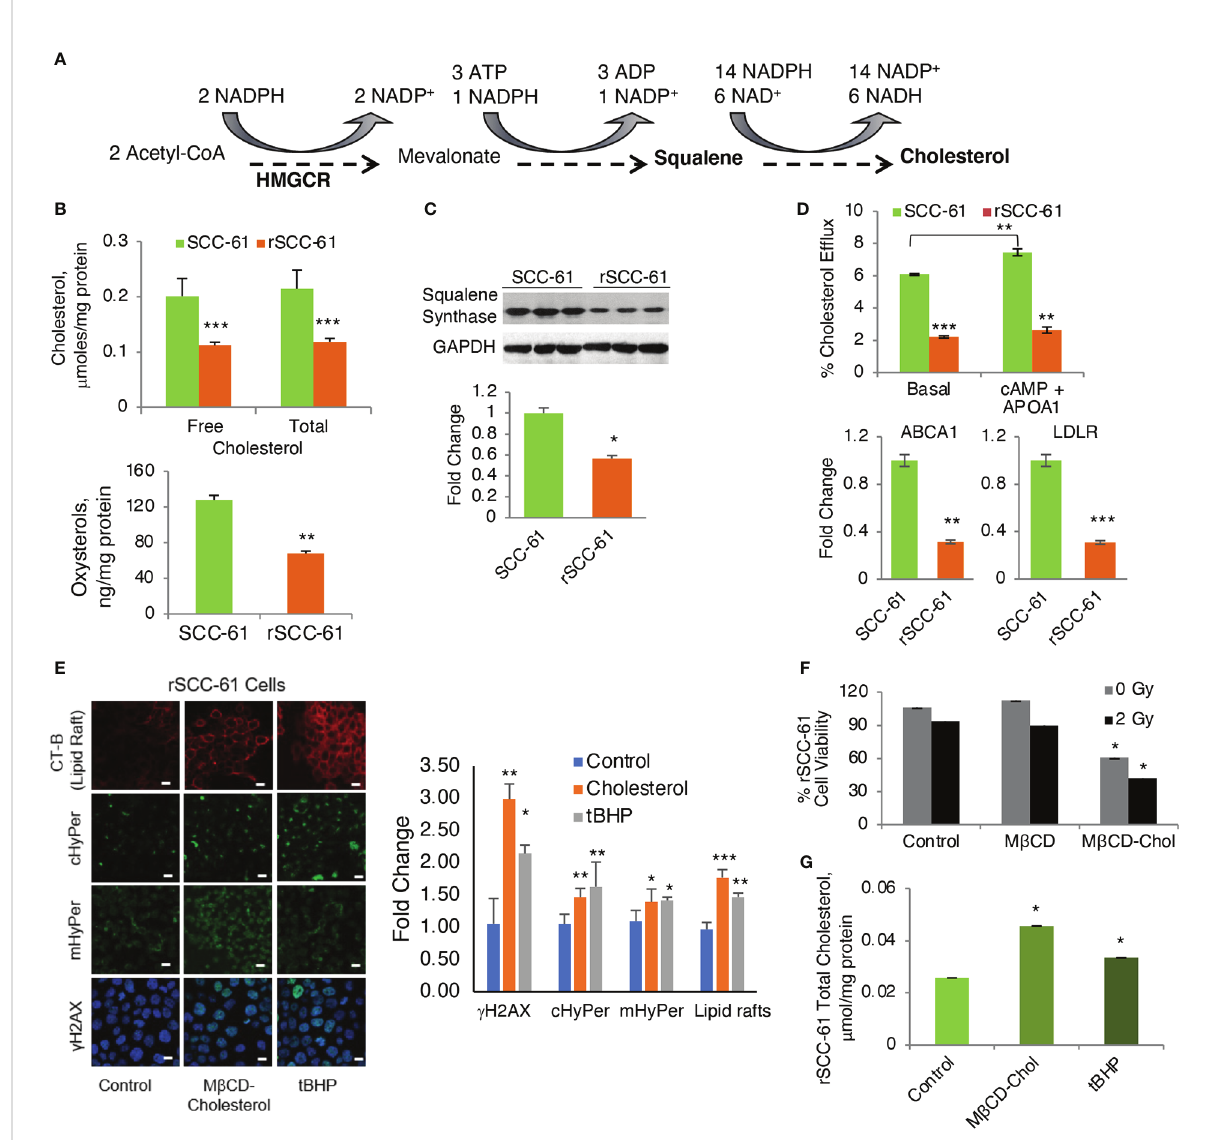
FIGURE 6 Regulation of Cholesterol and Its Impact on the Response to Radiation. (A) Abbreviated schematic of cholesterol biosynthesis showing the key NADPH consuming reactions. (B) Quanti fi cation of cholesterol and oxysterols by mass spectrometry showing signi fi cantly decreased cholesterol and oxysterols in rSCC-61 cells ( p values **0.01-0.001, ***<0.001, n=3). (C) Western blot analysis of squalene synthase showing decreased expression in rSCC-61 compared to SCC-61 cells. Quanti fi cation is shown in the lower panel ( p value *0.05-0.01). (D) Cholesterol ef fl ux and uptake showing (upper) basal and maximal ef fl ux in SCC-61 and rSCC-61 cells after treatment with cAMP and human APOA1, and (lower) Relative quanti fi cation of ABCA1 responsible for the ef fl ux offree cholesterol and LDLR involved in the uptake of cholesterol esters in SCC-61 and rSCC-61 cells show both their gene transcript levels to be lower in rSCC-61 cells ( p values **0.01-0.001, ***<0.001, n=3). (E) (left) Fluorescence imaging of lipid rafts with cholera toxin-beta (CT-B), cytosolic and mitochondrial H 2 O 2 production with HyPer and DNA damage with g H2AX in rSCC-61 cells after treatment with 1 mM M b CD-cholesterol complex and 1 mM tBuOOH showing increased lipid rafts, H 2 O 2 , and nuclear g H2AX foci formation (scale bar: 100 m m). Quanti fi cation is shown on the right panel ( p values *0.05-0.01, **0.01-0.001, ***<0.001, n=3). (F) MTT assay of cell viability of rSCC-61 cells at 48h after treatment 1 mM M b CD- cholesterol complex and 2 Gy irradiation demonstrating increased sensitivity to radiation ( p values *0.05-0.01, n=3). (G) Increased total cholesterol in rSCC-61 cells treated with 1 mM M b CD-cholesterol complex or 1 mM tBuOOH ( p value *0.05-0.01,